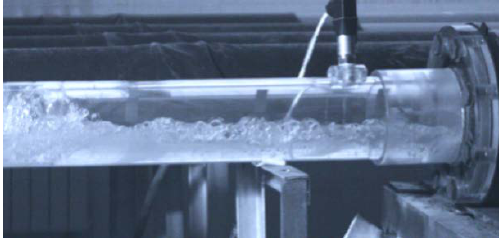
Figure 4. State with both flow interruption cavity and atomized vaporization zones.